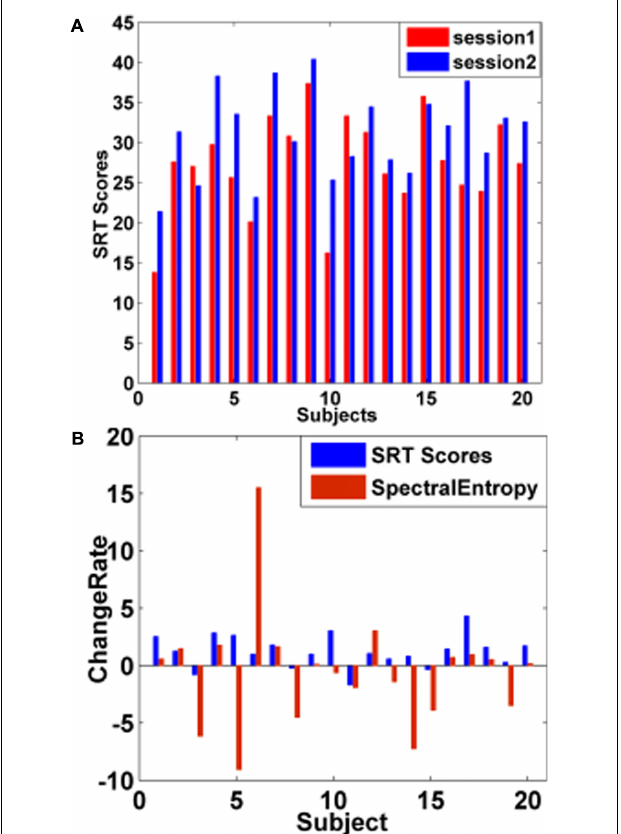
FIGURE 6 | WM performance changes by short-time training. (A) Changes in subjects’ SRT scores before and after training. The red bar represented the subjects’ SRT scores before training, and the blue bar denoted the subjects’ SRT scores after training. After training, 16 subjects’ SRT scores increased and 4 subjects’ SRT scores showed a downward trend. (B) Change rate (CR) of subjects’ SRT scores and spectral entropies between sessions. The blue bar represented the CR of subjects’ SRT scores, and the red bar denoted the CR of spectral entropies before and after